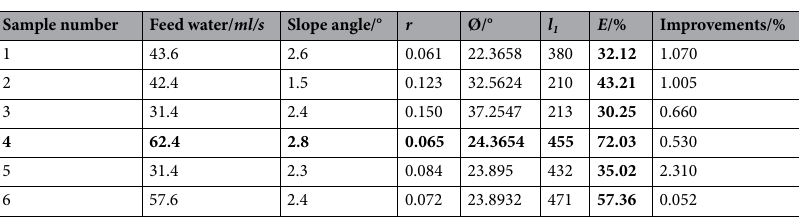
Table 6. Combination of control parameters and characteristic parameters of ore belt after one optimization.